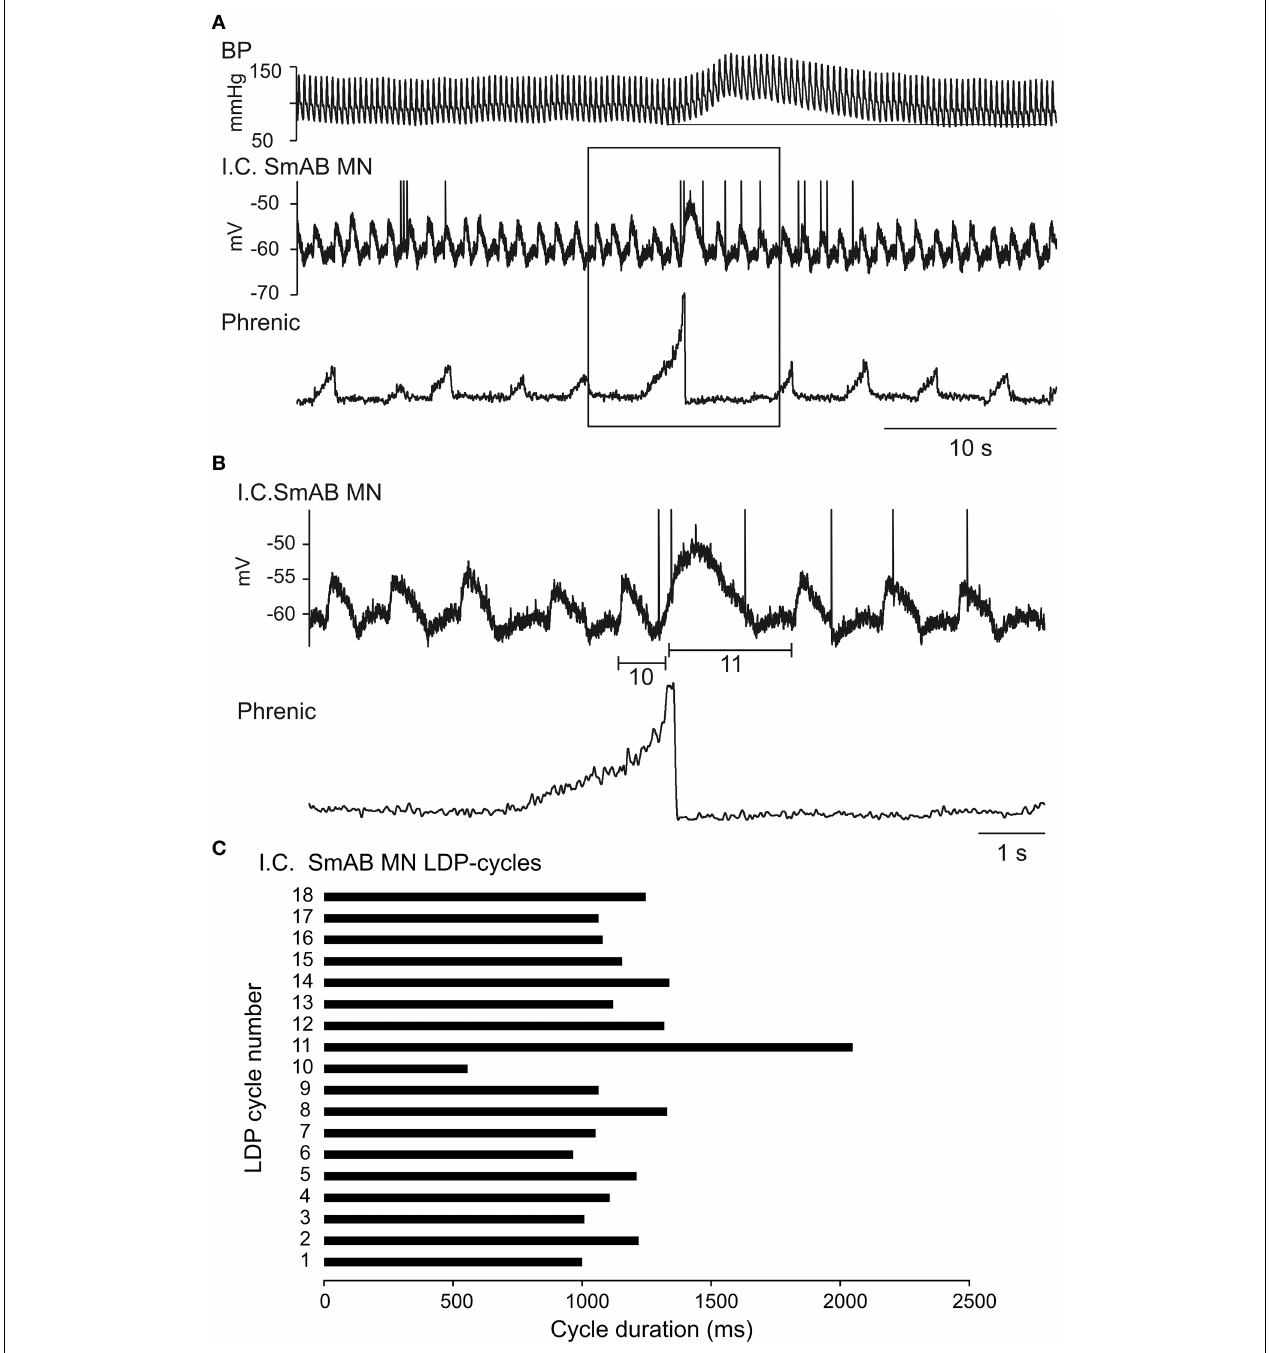
FIGURE 5 | Demonstration of the interaction between a regular LDP and a single large post-inspiratory depolarization at the beginning of a Mayer wave event. In (A) is shown a rather long-lasting recording of BP, intracellular recording from a SmAB motoneuron and the rectified phrenic